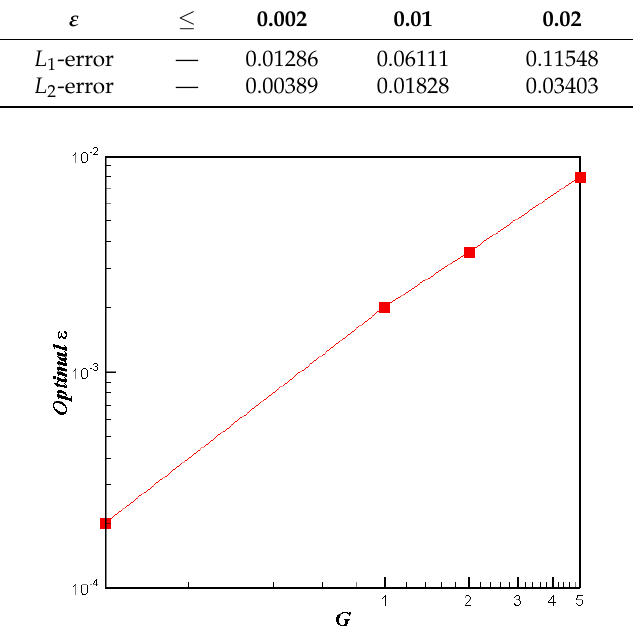
ε and G. Figure 3. Relationship between optimal ε and ε and G.